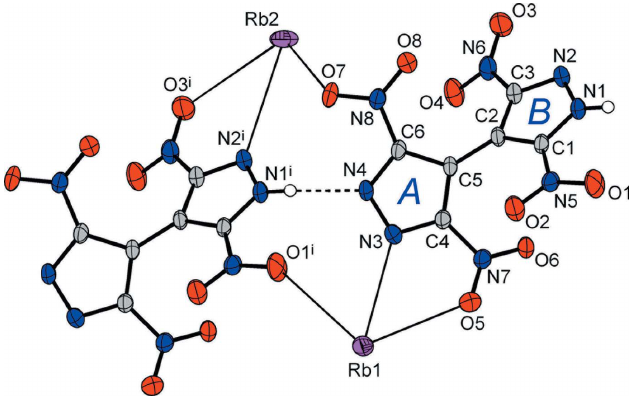
Figure 1 The molecular structure and the atom-labeling scheme for ( 1 ) [the atom labeling for ( 2 ) is identical, with Cs1 and Cs2 instead of Rb1 and Rb2], with displacement ellipsoids drawn at the 50% probability level and the N—H (cid:2)(cid:2)(cid:2) N hydrogen bond shown as a dashed line. [Symmetry code: (i) x , y + 1, z .]